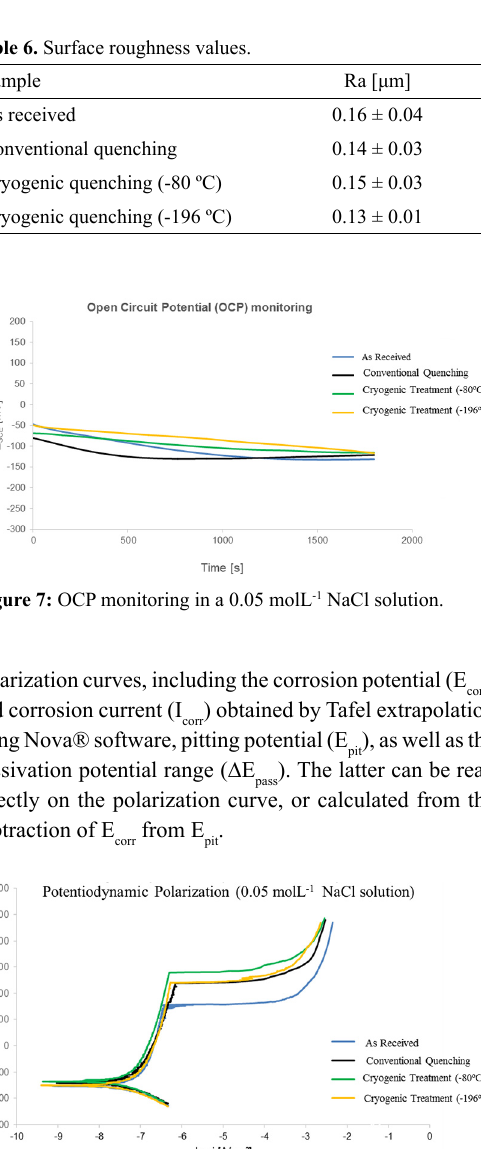
Figure 8: Potentiodynamic polarization curves in a 0.05 M NaCl solution; -100 mV vs. OCP to +600 mV vs. OCP; 1 mV.s-1.